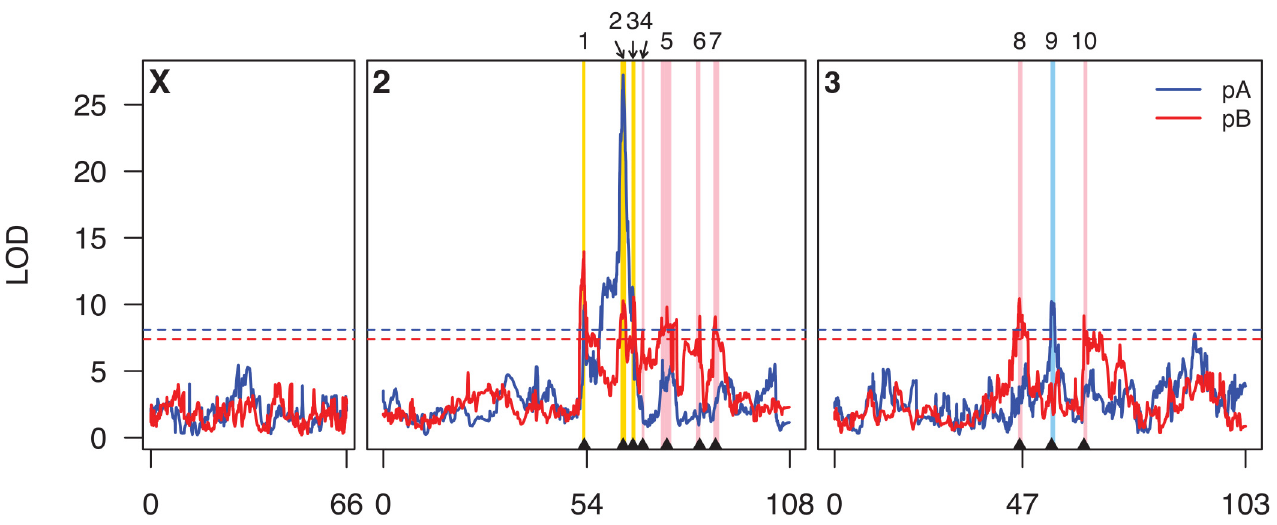
Fig 1. Genome scan for caffeine resistance QTL. Scans for population pA and pB are shown in blue and red curves, respectively, and the horizontal dotted lines represent population-specific genomewide 5% permutation thresholds (pA, LOD = 8.1; pB, LOD = 7.4). Genetic distances along the chromosomes are indicated along the x -axis. The centromeres are at positions 54 and 47 on chromosomes 2 and 3, respectively. The positions of the ten QTL we describe in the text are indicated on the plot for ease of reference. Intervals implicated by these QTL are highlighted as vertical bars, with pA-specific QTL in light blue, pB-specific QTL in pink, and QTL identified in both panels in yellow.